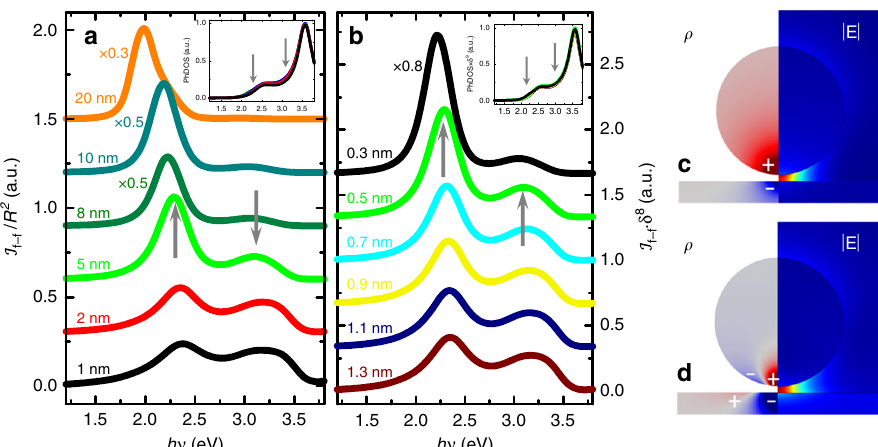
Fig. 2 Modelling the tip-surface nanocavity. Theoretical far- fi eld (main panels) and PhDOS (insets) spectra for nanocavities comprising a gold sphere (tip) on top of a silver fl at surface (substrate). Vertical dotted lines mark the peak maxima. a Spectra for different sphere radii, R , and 0.5 nm gap size, δ . b Spectra for different gap size, δ , and fi xed sphere radius, R = 5 nm. The green curve plots the same spectrum in both panels. c , d render induced charge distribution (left) and electric fi eld amplitude maps (right) for the two radiative plasmonic modes behind the far- fi eld peaks indicated by grey arrows in a , b